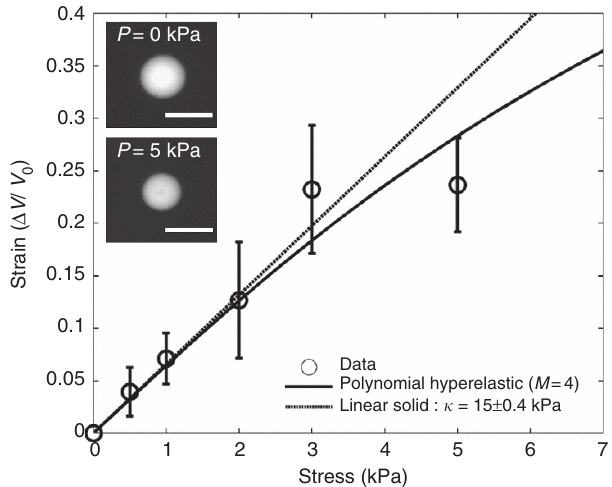
Figure 2 | Determination of bulk modulus of PAA microbeads (5/0.225).